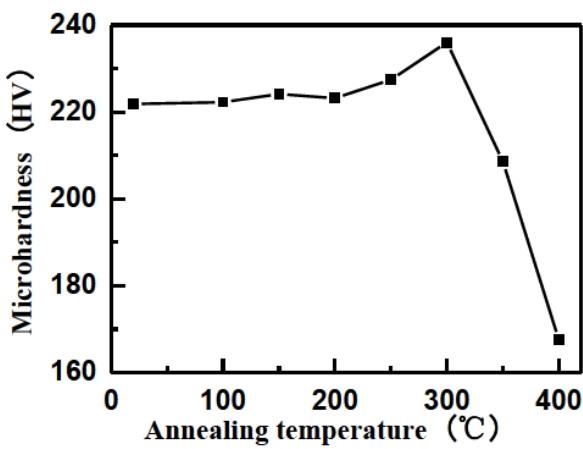
Figure 3: Microhardness of Cu-7%Al alloy as a function of the an- nealing temperature.